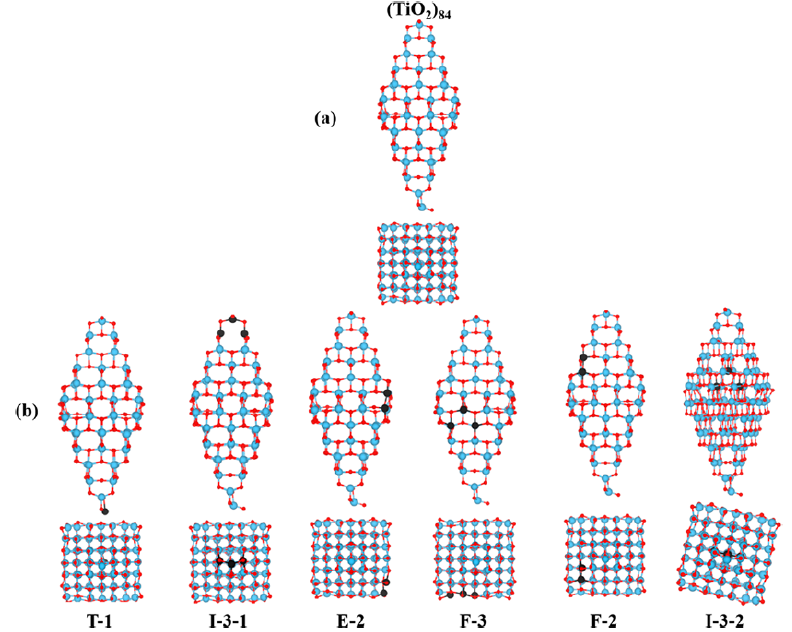
Figure 3. The (TiO 2 ) 84 anatase nanoparticle of 3 nm size with (101) facets ( a ) and oxygen vacancies in it ( b ). Reproduced from Reference [23] with permission; copyright (2018) ( b ). Reproduced from Reference [23] with permission; copyright (2018) American Chemical American Chemical Society.